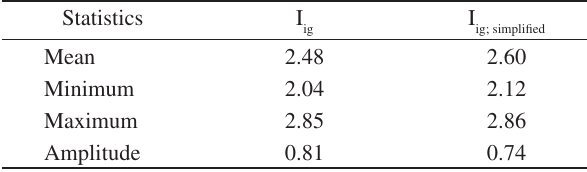
e I . ig ig; simplified